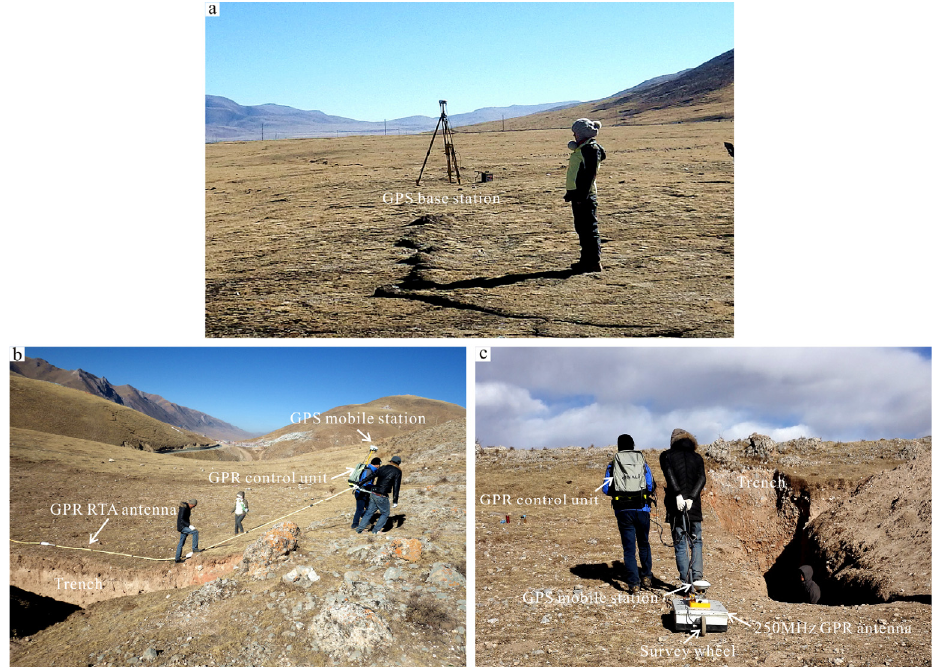
Figure 4. GPR data acquisition. ( a ) GPS base station. ( b ) GPR data acquisition with 25 MHz and 100 MHz RTA antenna. ( c ) GPR data acquisition with 250 MHz and 500 MHz shielded antenna. Table 2. GPR data processing